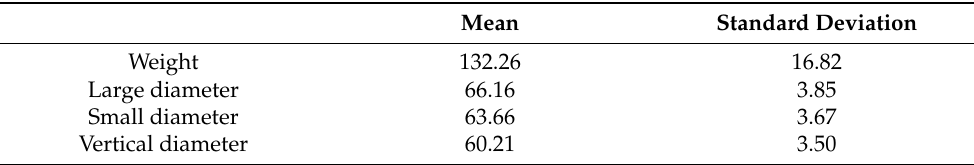
Table 1. Values of morphological